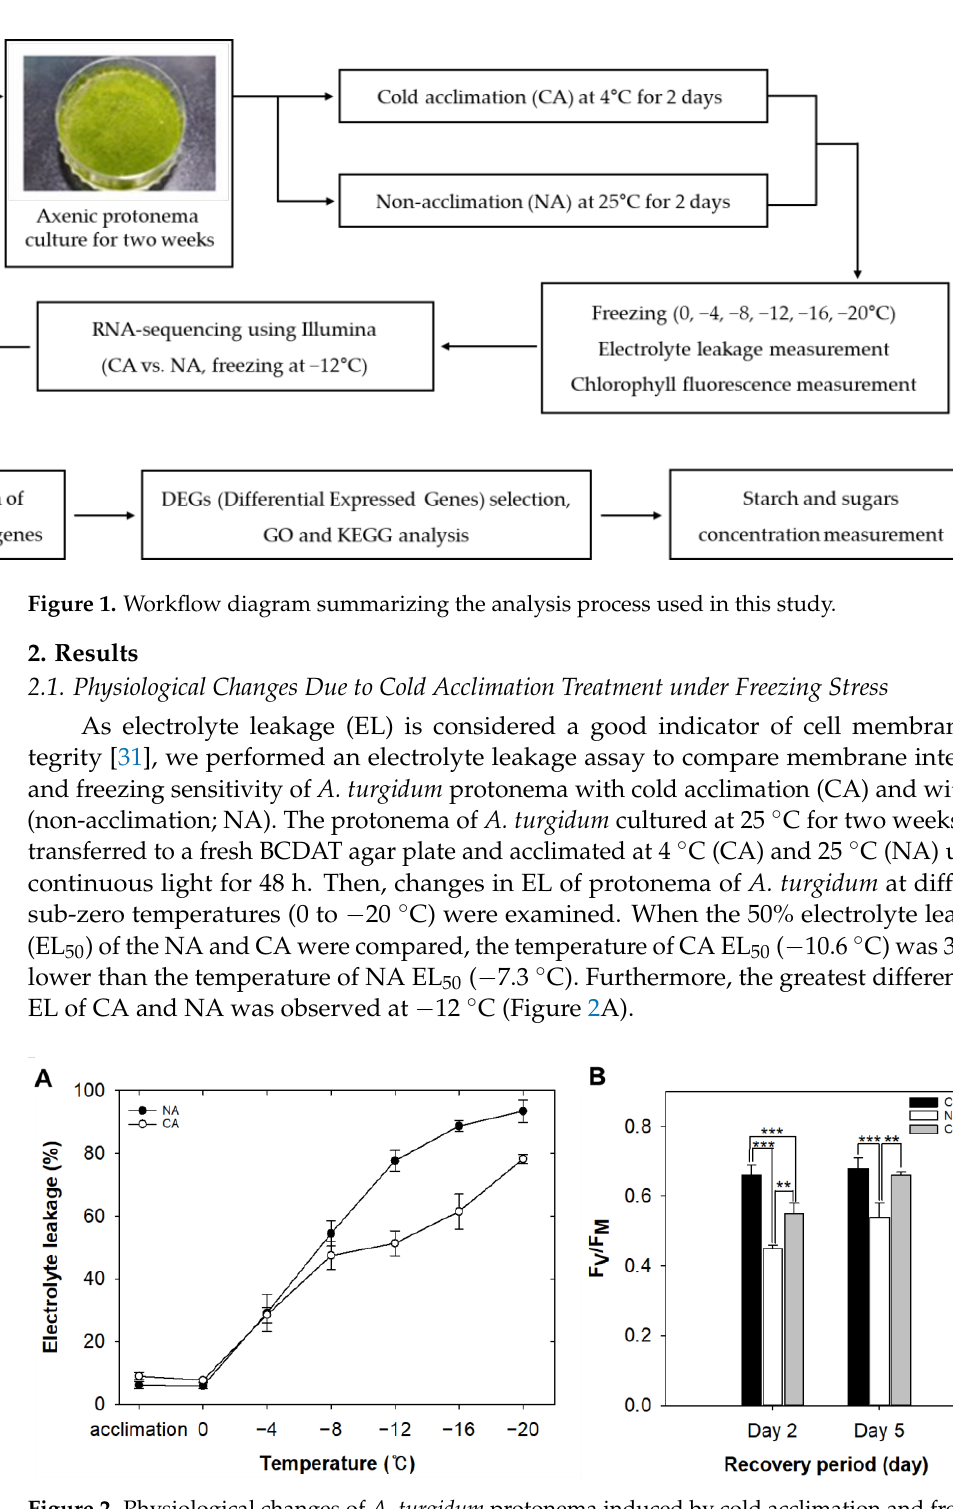
Figure 2. Physiological changes of A. turgidum protonema induced by cold acclimation and freezing stress. Freezing stress was applied to A. turgidum protonema at a rate of decreasing the temperature of 2 °C per hour. Electrolyte leakage change under freezing stress for CA and NA ( A ). The maximum photochemical efficiency of photosystem II (F V /F M ) values of CA-12 and NA-12 during recovery from freezing ( B ). Data are means ± SD of three repeats (***, p < 0.001; **, p < 0.01, Student t -test). CA, cold-acclimated A. turgidum at 4 °C for 2 days; NA, non-acclimated A. turgidum at 25 °C for 2 days; CA-12, CA exposed to freezing until − 12 °C; NA-12, NA exposed to freezing until − 12 °C.